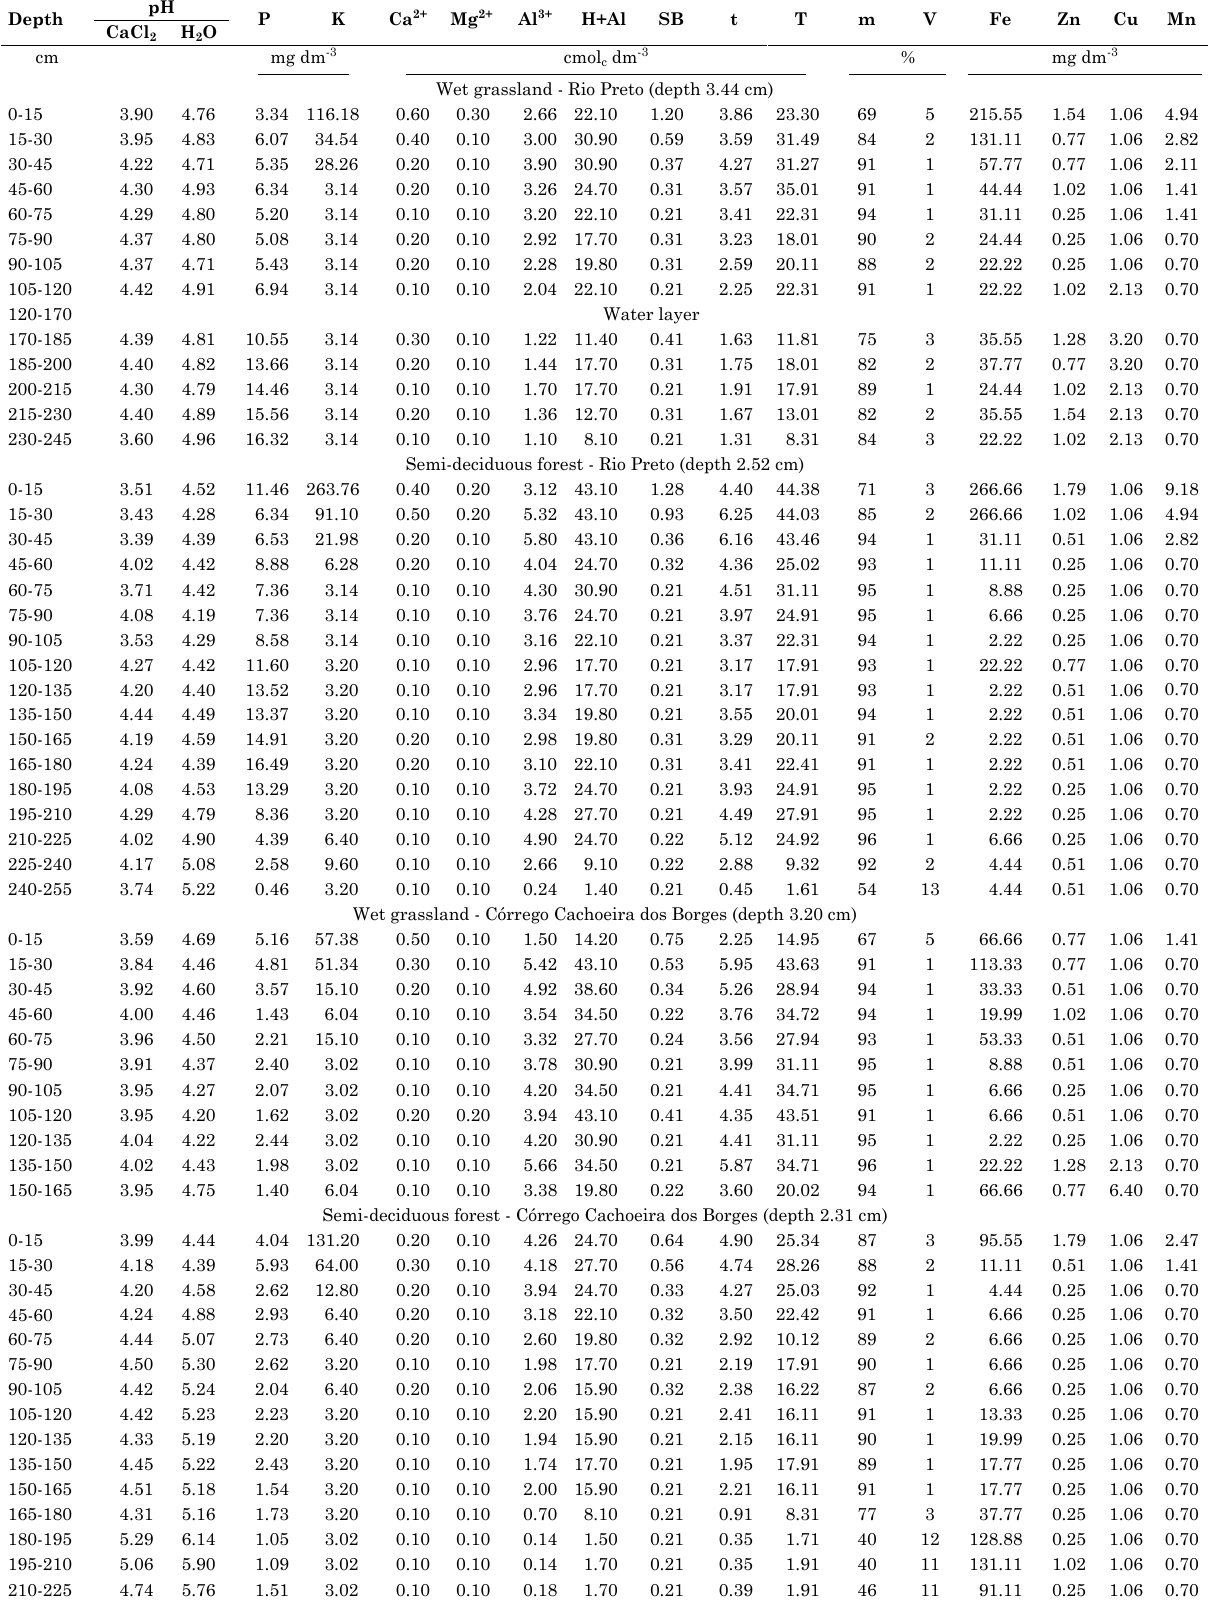
Table 2. Chemical properties of peat soil under two vegetation types from the headwaters of tributaries of the Rio Araçuaí (average of two observations)